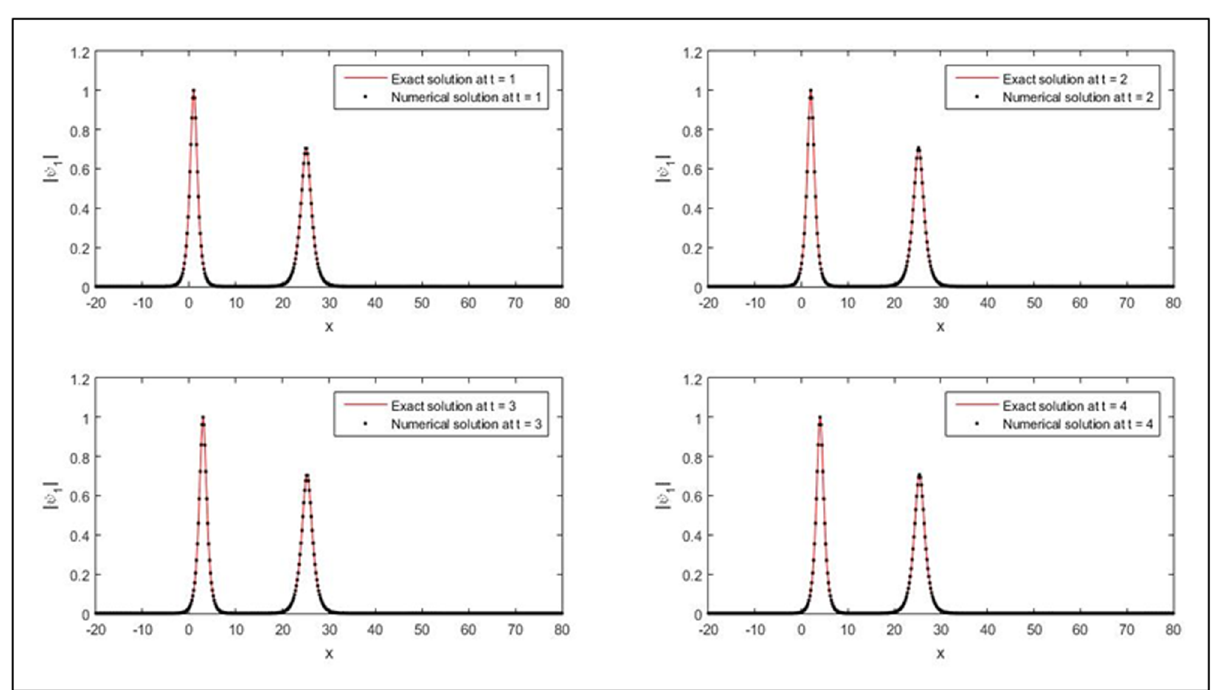
Figure 3: Numerical and exact values of fi rst - wave amplitudes, respectively, for = N 501 , and = τ 1 at = t 1 , 2, 3, and 4 [ −20, 80 ]